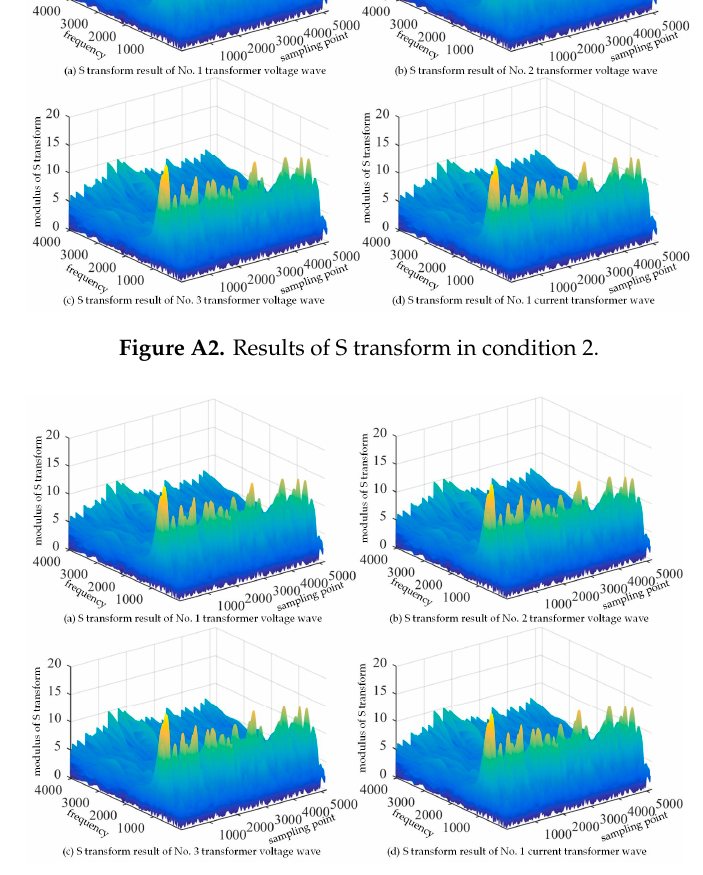
Figure A3. Results of S transform in condition 3.